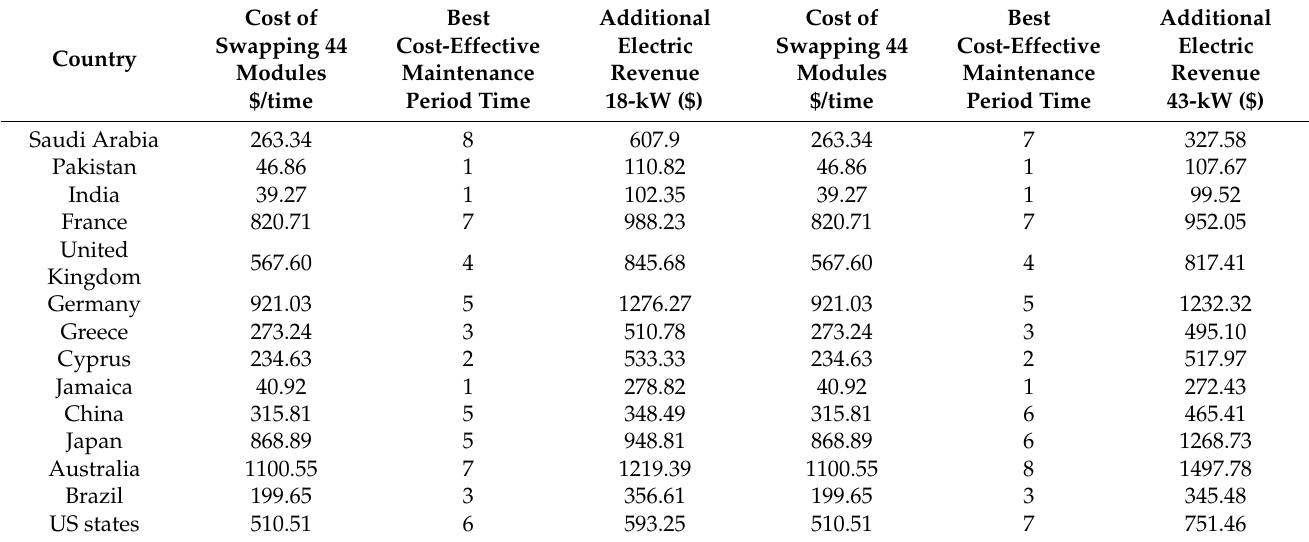
Table 7. Assessment of economic advantages taking into account minimum handling times.